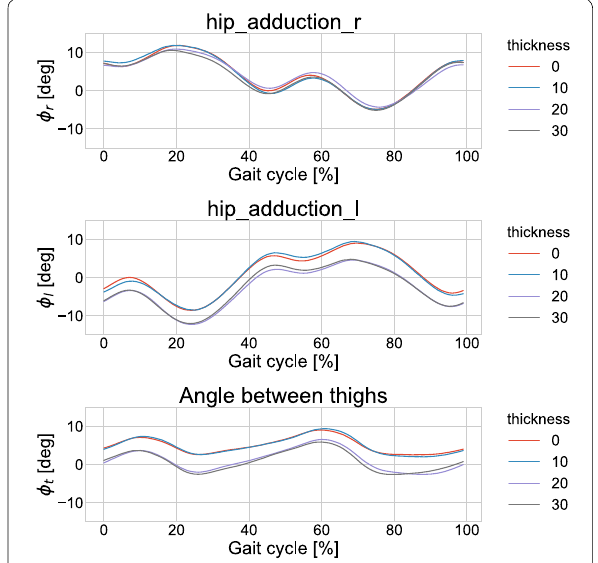
Fig. 5 Thigh motion at adducting/abducting direction during running. Positive φ r and φ l , and negative ones represent hip adduction and hip abduction, respectively. Positive and negative values of φ t represent thighs opening and closing in the coronal plane, respectively. 0% and 100% gait cycle ratios represent the instants of right heel